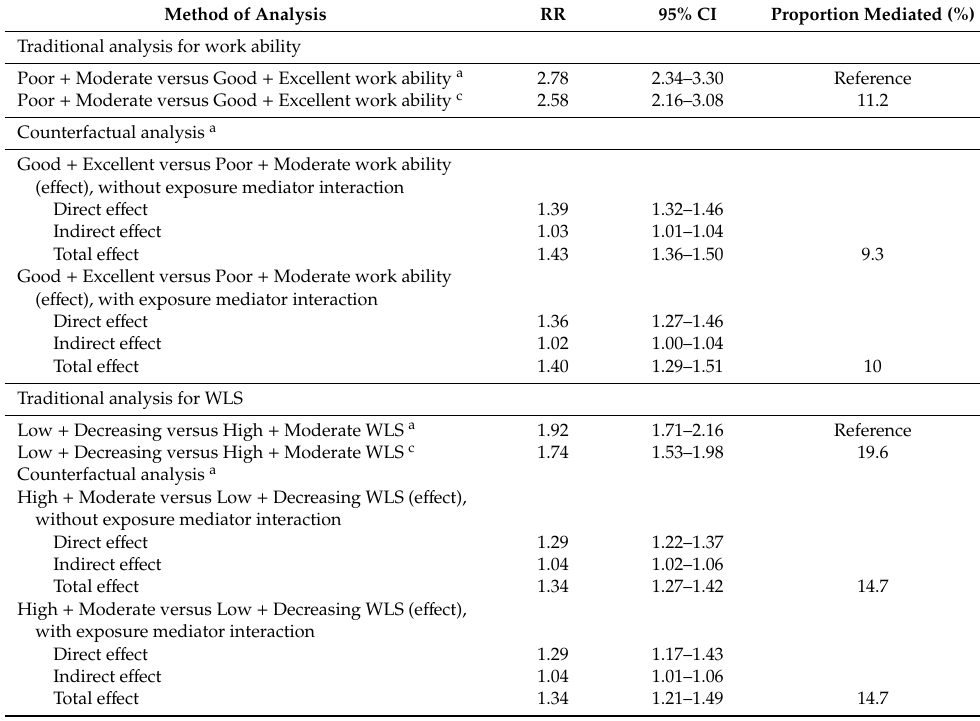
Table 6. Risk Ratio (RR) and 95% CI on the association between exposures (work ability and satisfaction in work life (WLS)) and outcome (intention to retire) with Job Control as the